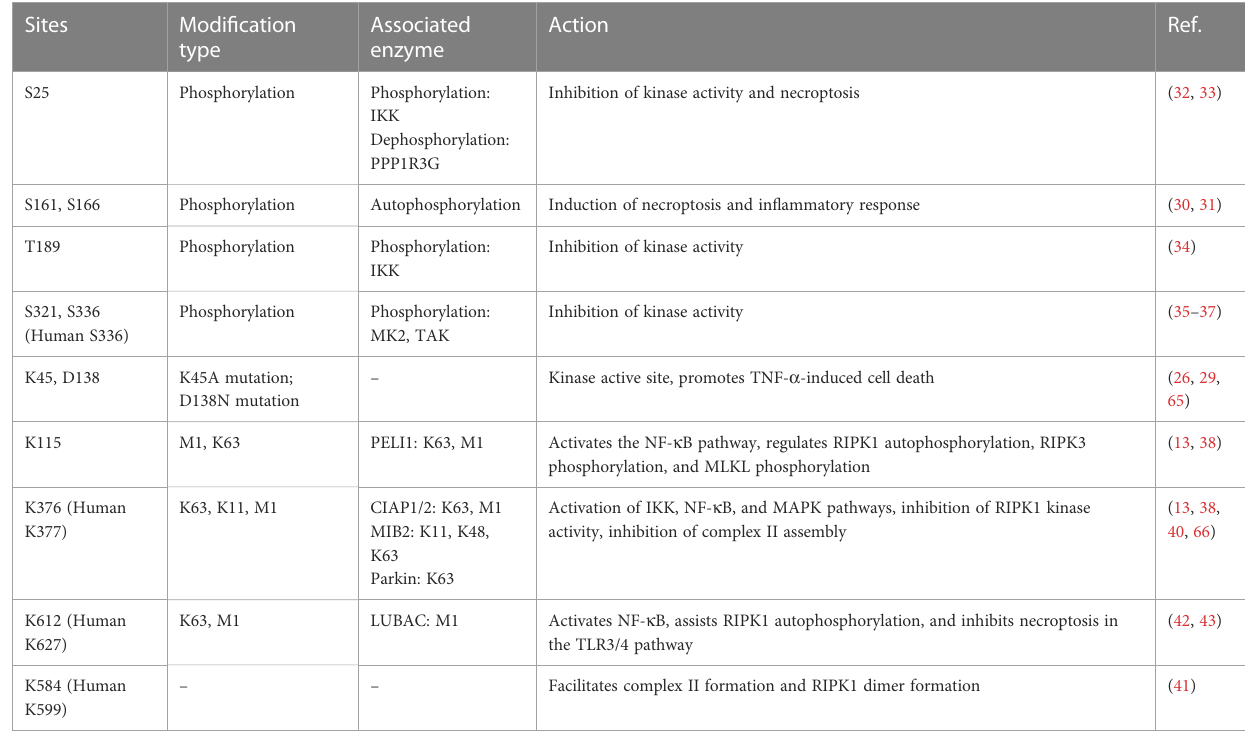
TABLE 1 Ubiquitin and phosphoryl sites of